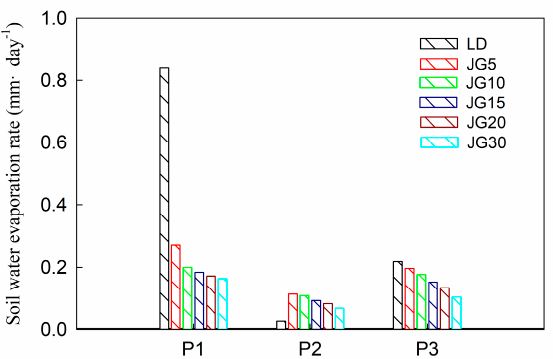
Figure 8. Soil water evaporation rate with different straw mulch thicknesses during the three freeze–thaw stages.